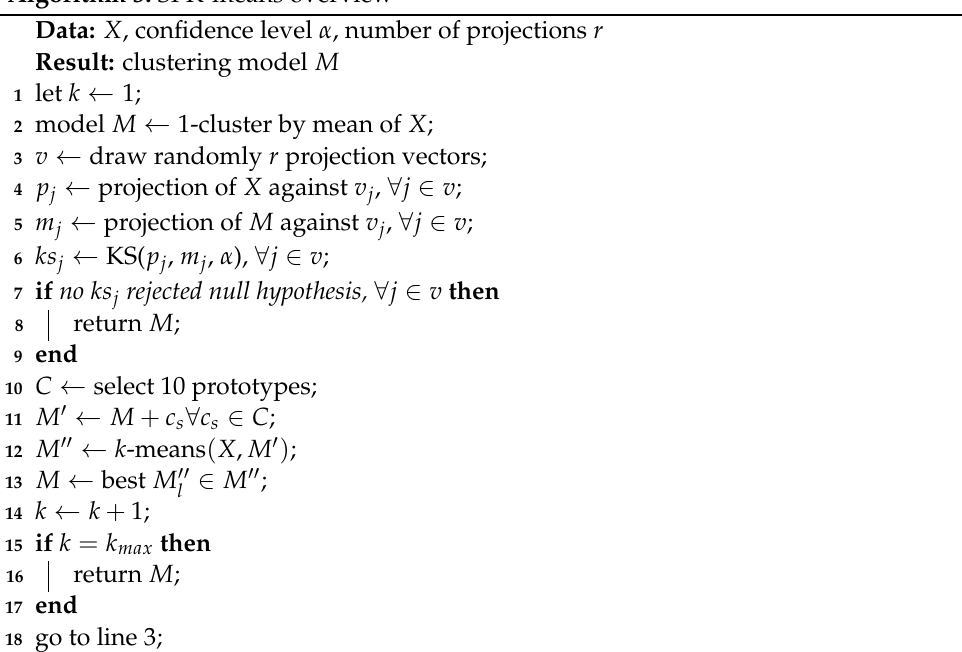
Algorithm 3: SPK-means overview Data: X , confidence level α , number of projections